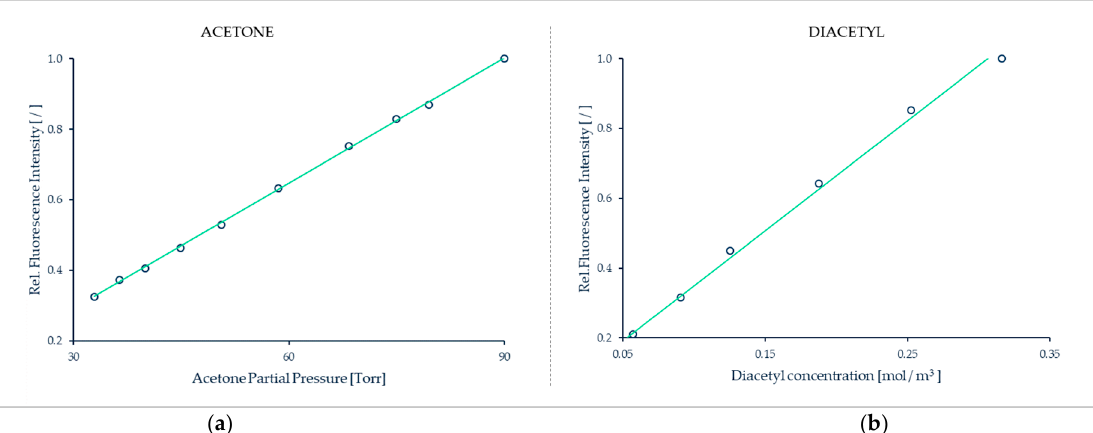
Figure 36. ( a ) Acetone fluorescence emission dependence on partial pressure, according to the data from Lozano et al. [171]; ( b ) Diacetyl fluorescence emission dependence on concentration (at constant temperature, this parameter is easily linked to pressure dependence), according to the data from Tomita et al. [183].